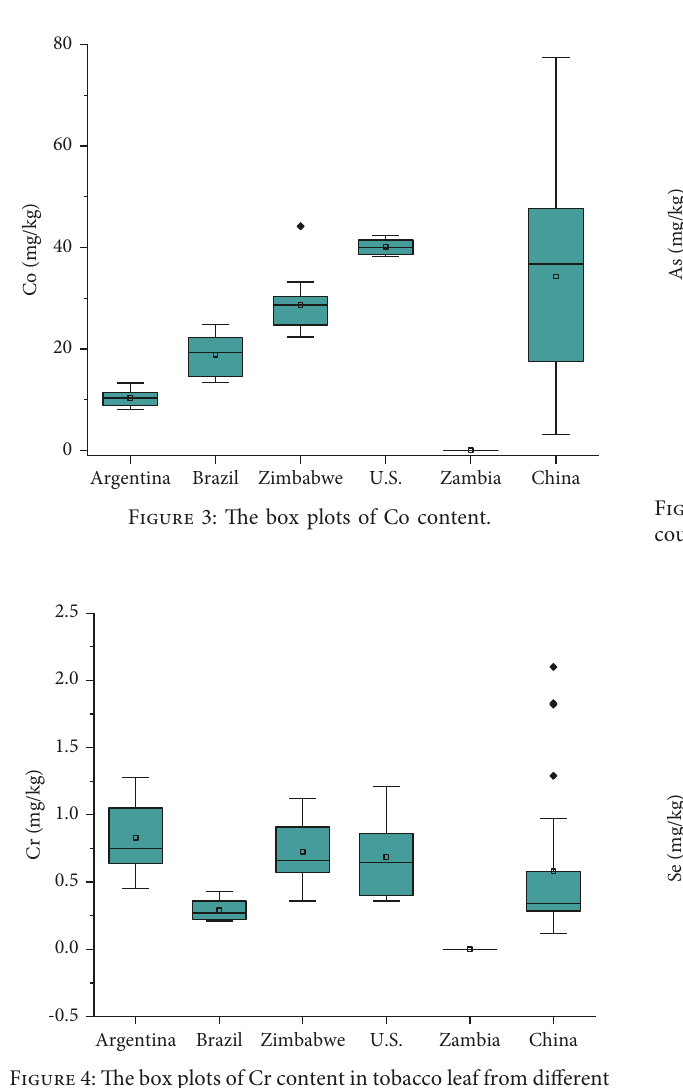
Figure 7: The box plots of Se